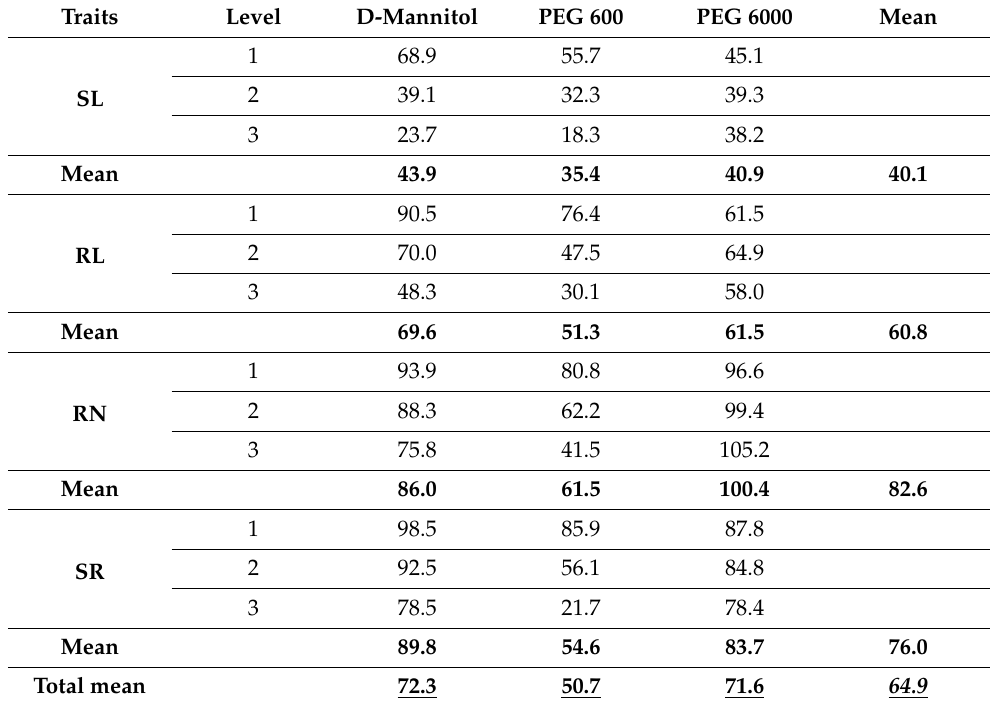
Table 1. The main effect of osmotic agents calculated from SI values for morpho-physiological traits on the average of all potato breeding lines at different osmotic stress levels. Traits Level